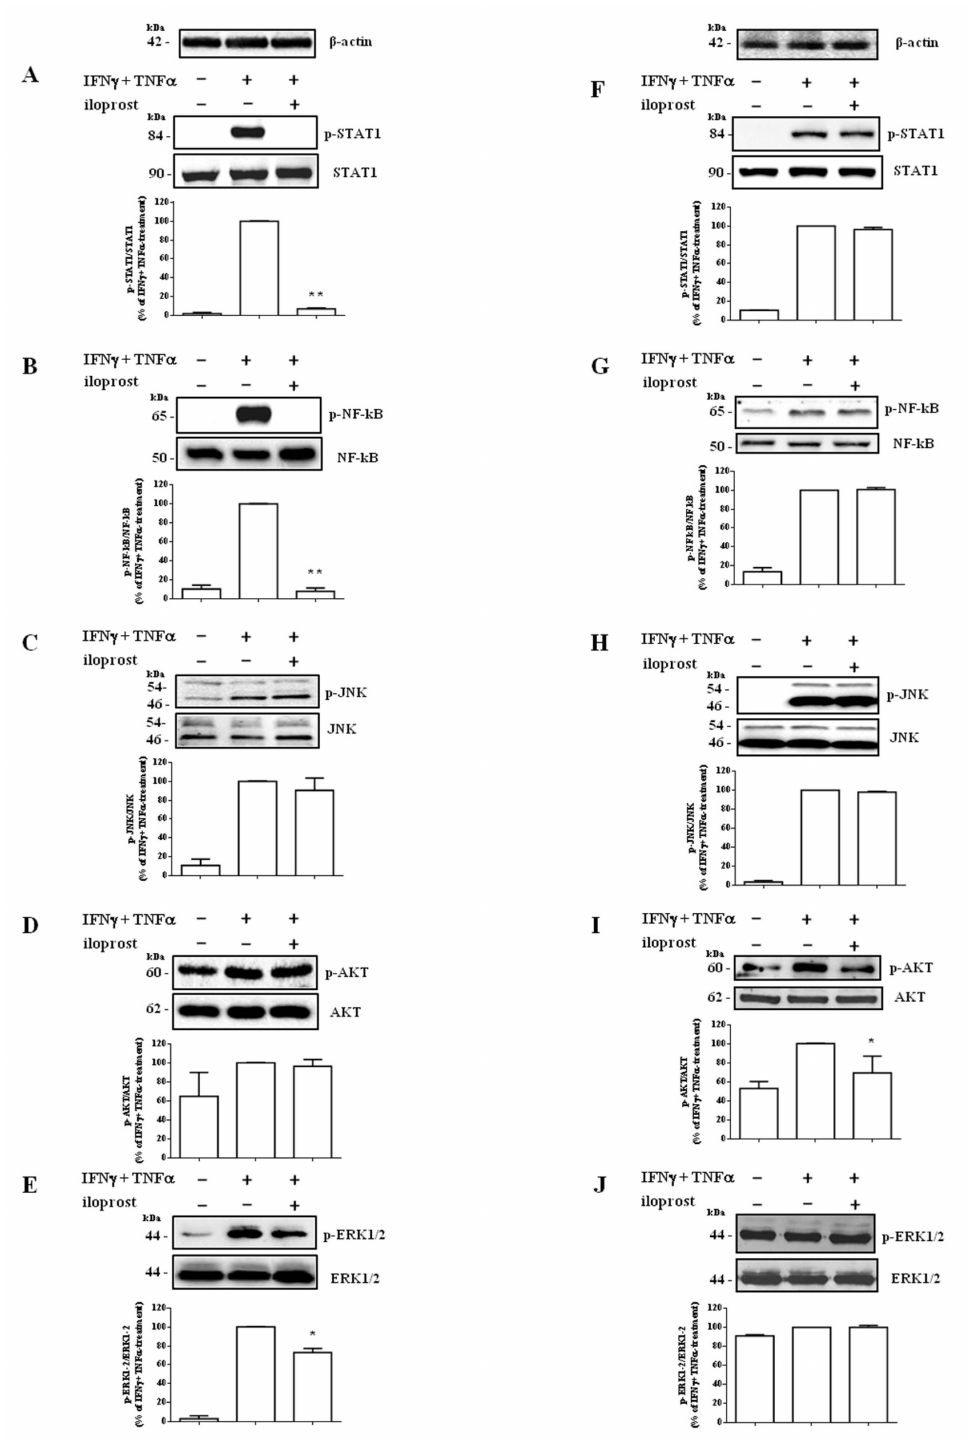
Figure 2. Iloprost-induced targeting of IFN γ and TNF α -dependent signaling cascade in human endothelial cells (Hfaec) and dermal fibroblasts (Hdf). ( A – E ) Western blot analysis in Hfaec